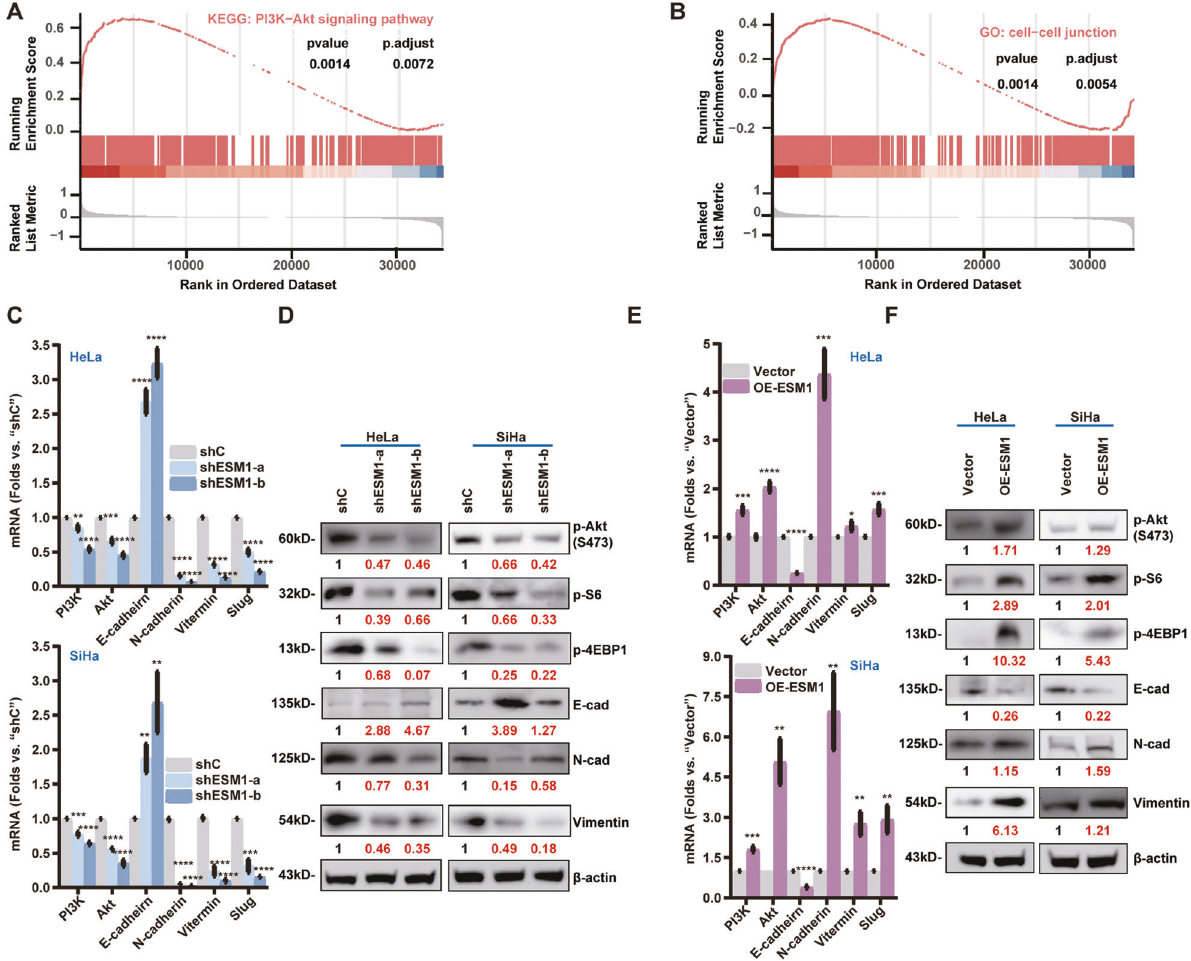
Fig. 4 ESM1 activates the PI3K signaling pathway and facilitate EMT in cervical cancer cells. Gene Set Enrichment Analysis of Gene Ontology ( A ) and pathway enrichment analyses ( B ) of differential expression genes (DEGs) between high-ESM1 and low-ESM1 expression cervical cancer tissues from TCGA database. PI3K , Akt , E-cadherin , N-cadherin , Slug , and Vimentin mRNAs were detected by qRT-PCR ( C and E ) in the described cervical cancer cells with the applied genetic modi fi cations. Expression of the listed proteins was tested by Western blotting assays ( D and F ). The data were presented as mean ± standard deviation (SD, n = 3). * P < 0.05, ** P < 0.01, *** P < 0.001, **** P < 0,0001 vs. “ shC ” / “ Vector ” cells. The experiments were repeated three times with similar results obtained.